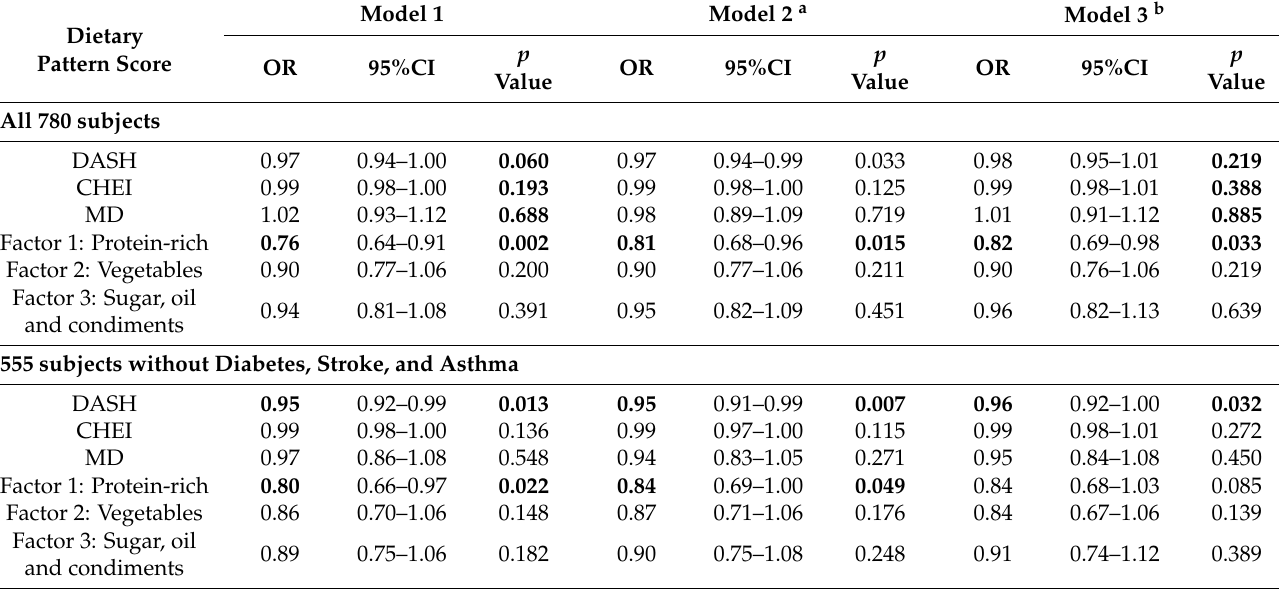
Table 4. Crude and adjusted associations between each dietary pattern score and frailty